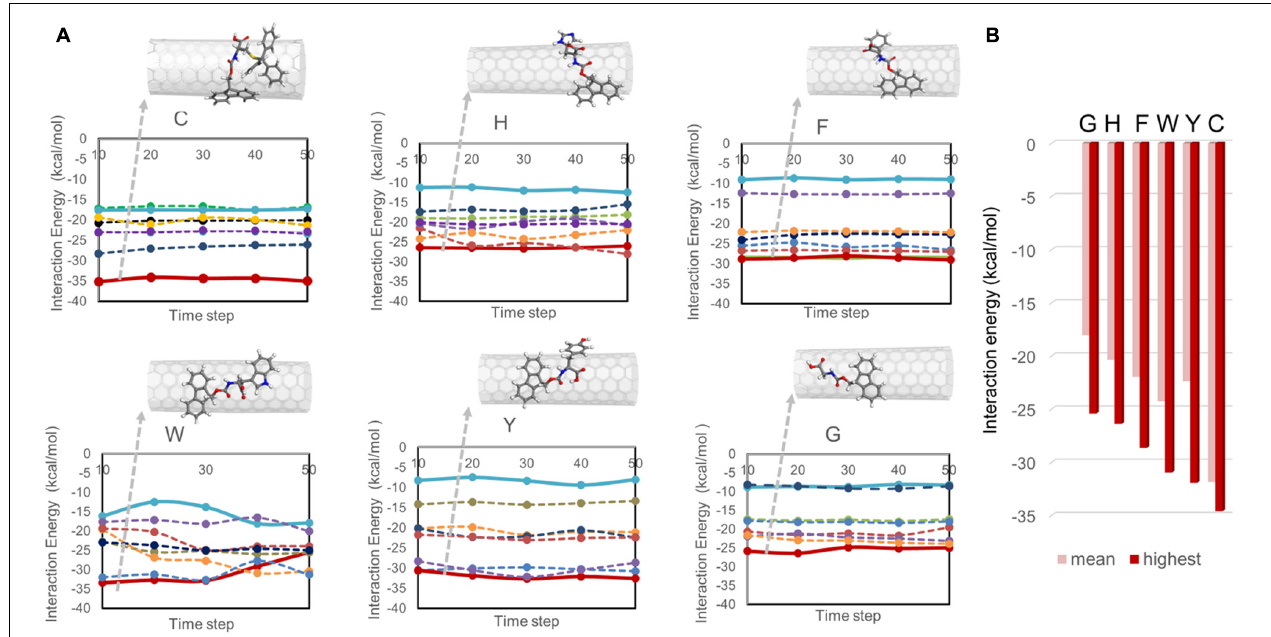
FIGURE 2 | Interaction energies between Fmoc – amino acids and SWNT calculated from quench MD simulations. In (A) , the interaction energies are plotted with respect to the simulation trajectory. In (B) , the mean and highest interaction energies for seven Fmoc derivatives per system are shown.